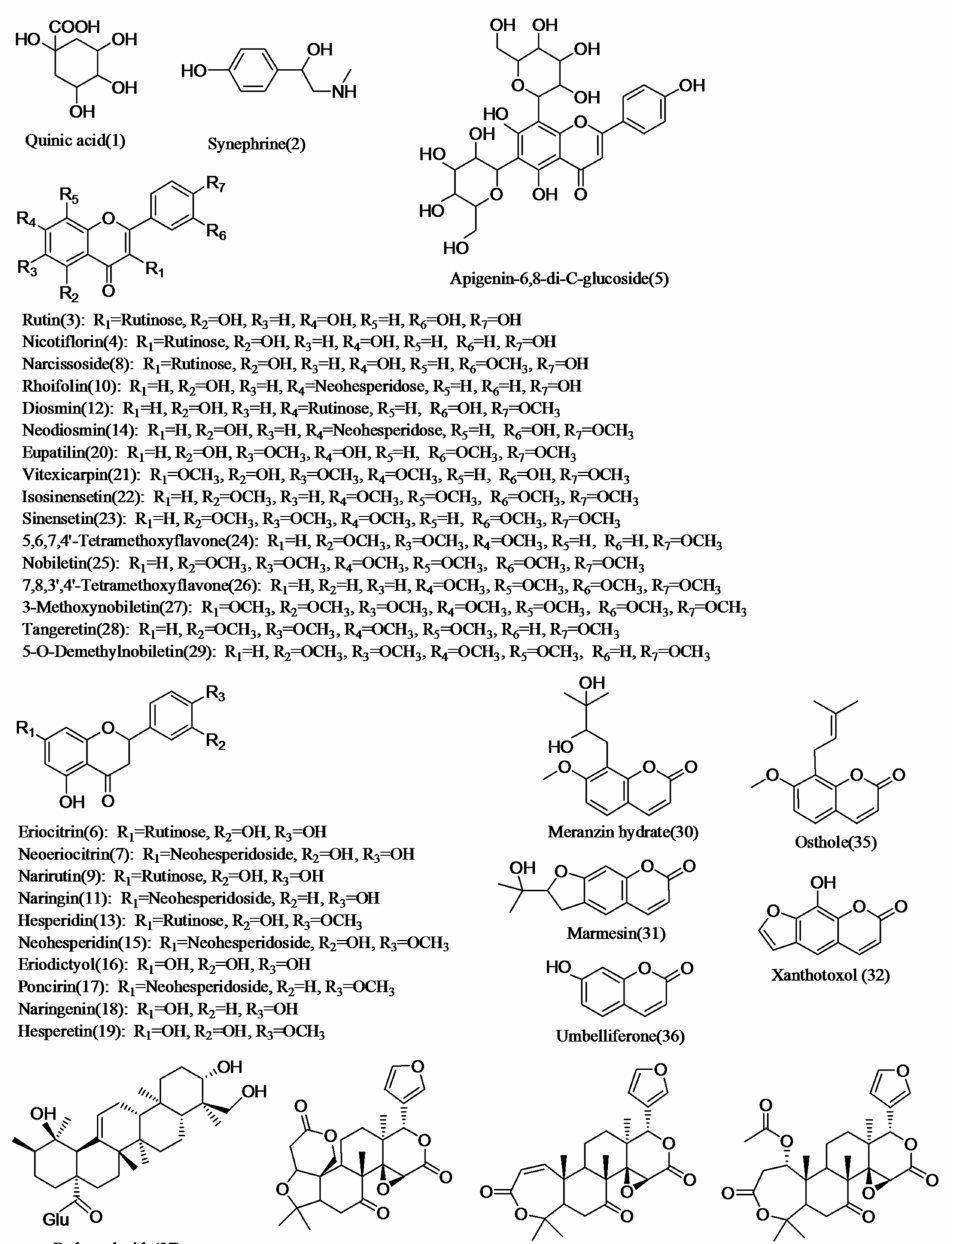
Figure 1. Chemical structures of compounds detected in Aurantii Fructus (AF) and Aurantii Fructus Immaturus